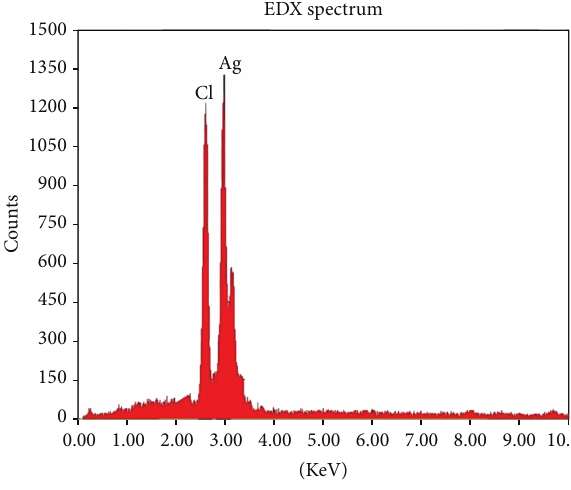
Figure 5: EDX analysis of silver nanoparticles.